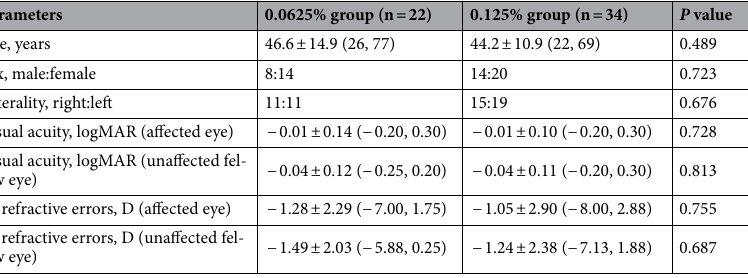
Table 1. Baseline characteristics of patients with unilateral Adie’s tonic pupil in both pilocarpine dosage groups. D, diopters; logMAR, logarithm of the minimum angle of resolution; SE, spherical equivalent. Data are mean ± standard deviation (min, max) unless otherwise